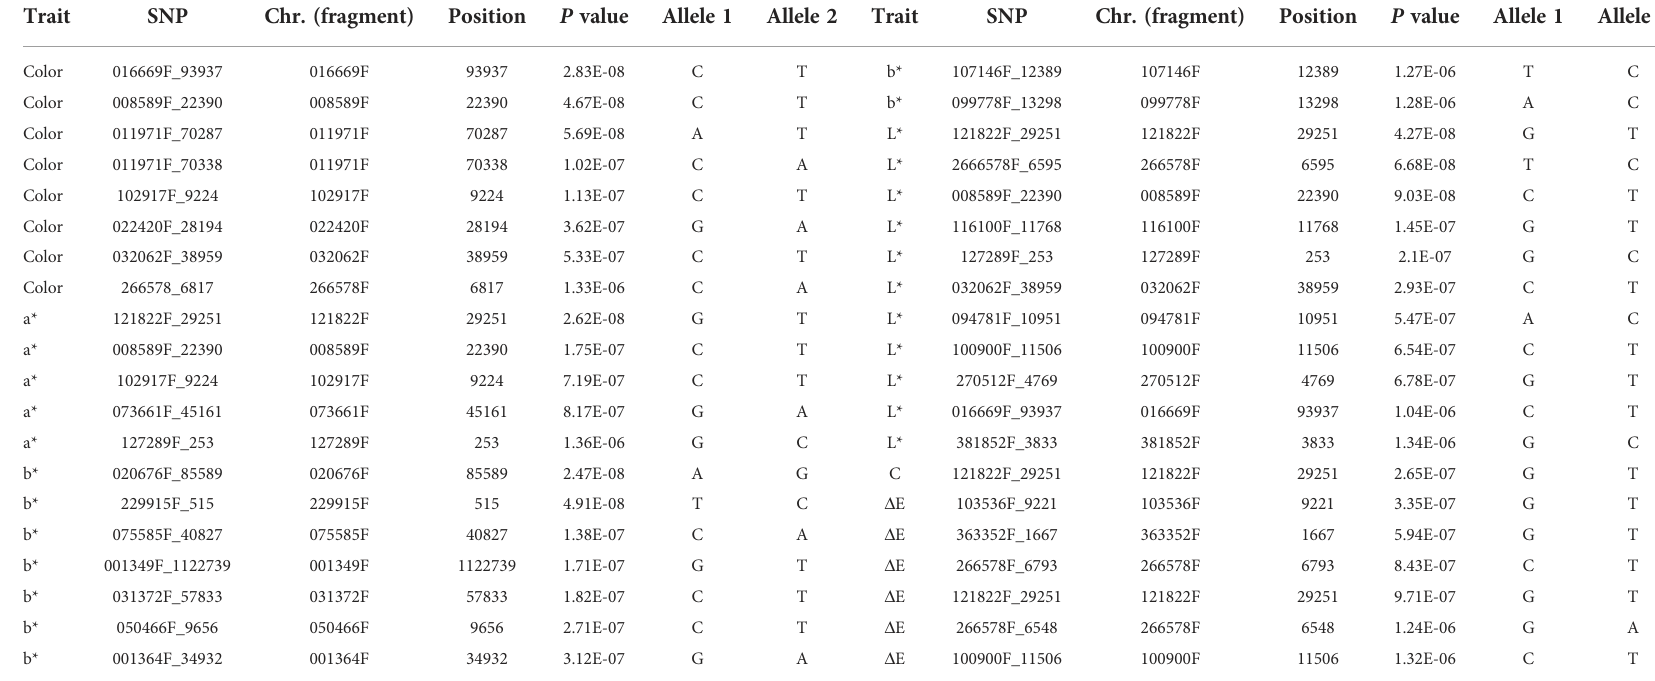
TABLE 3 SNP loci signi fi cantly associated with color traits in 99 P. lacti fl ora